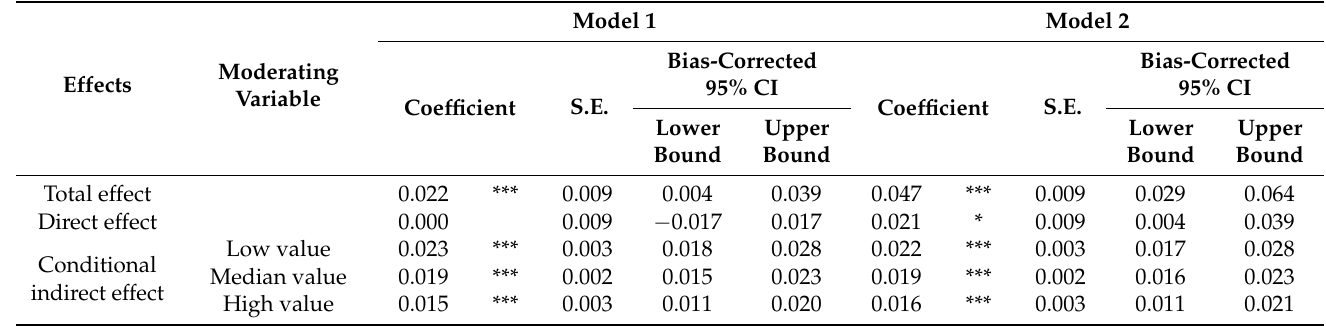
Table 2. Moderated mediating effect estimated results (Bootstrap =